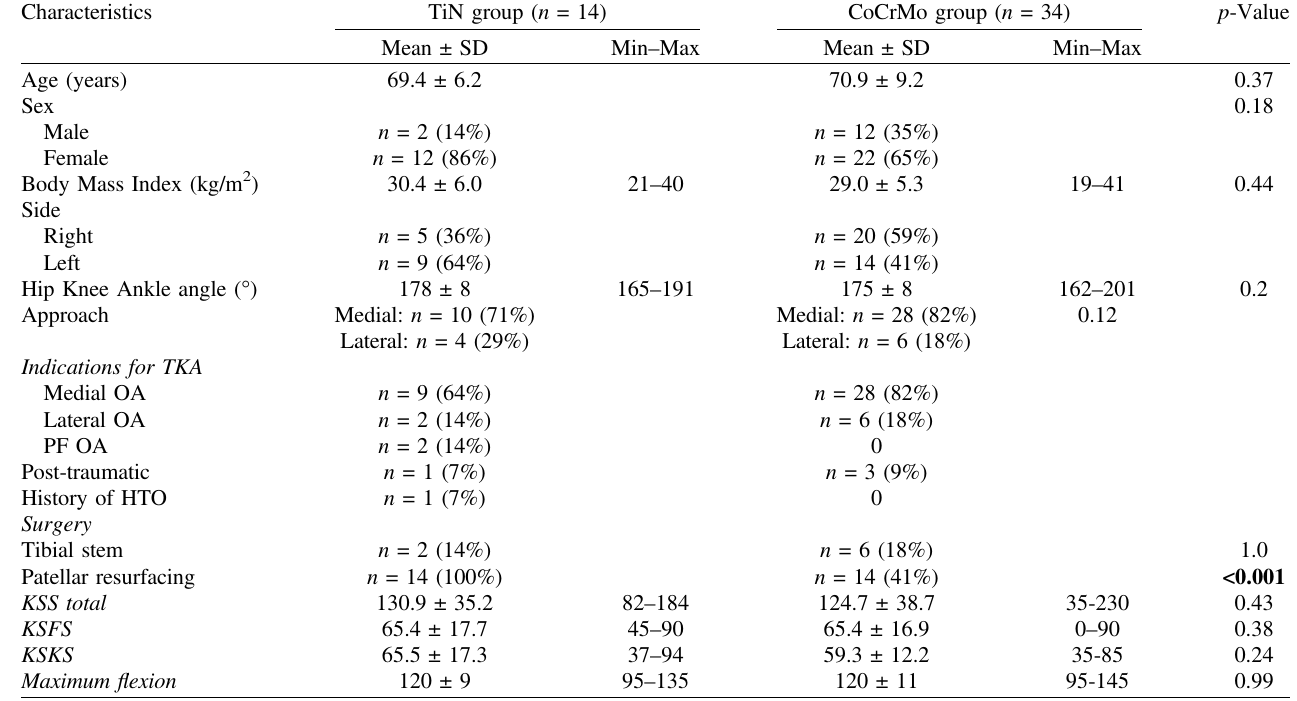
Table 2. Characteristics of the groups before surgery.